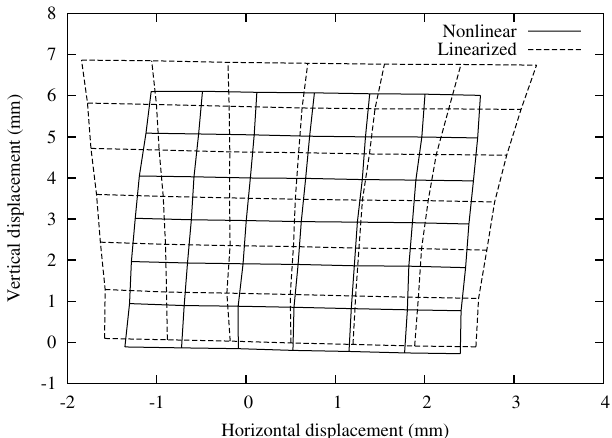
FIG. 6. Separator scan. Orbits at detector 9W calculated using linearized (dashed) and nonlinear (solid) methods.